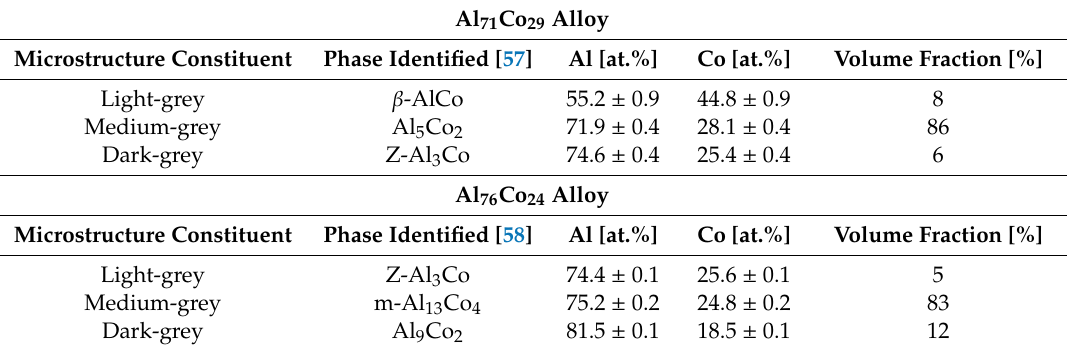
Figure 3. Microstructure of the as-solidified Al 76 Co 24 alloy.